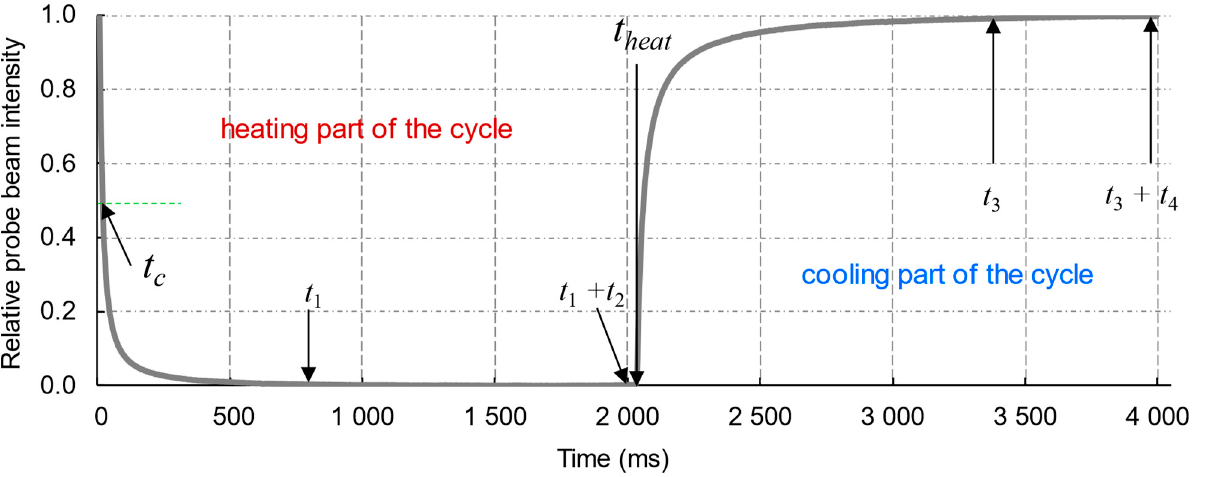
Figure 2. Single excitation on/off cycle: a normalized thermal-lens curve, Equation (6), in back- synchronized mode for measurements of transient and steady-state thermal-lens signals exemplified by ferroin in NMP; TLS-60; excitation wavelength, 514.5 nm; excitation power, 25 mW. The selection of times t 1 , t 2 , t 3 , and t 4 in this figure is for the illustration of the principle only. For the cooling part of the cycle, times t 3 and t 4 are measured from the shutter-off trigger.